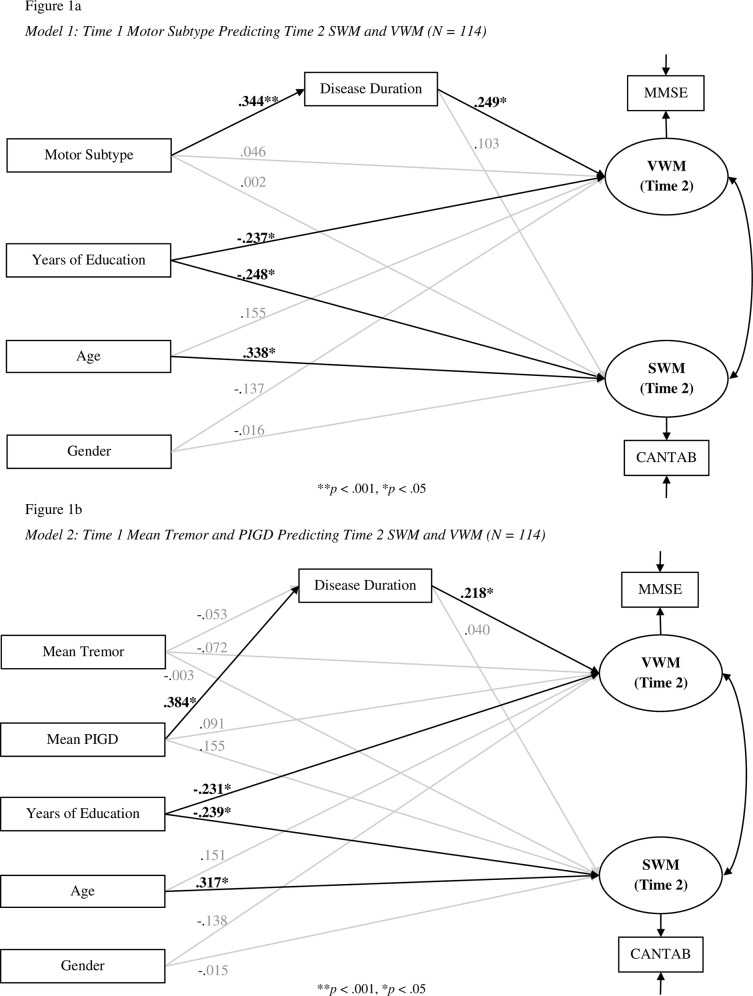
Path Diagrams of Analyses